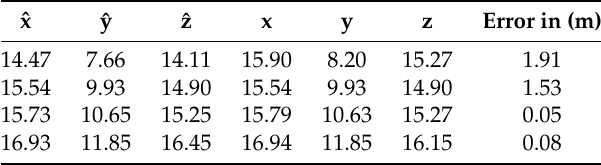
Table 2. Localization error of four nodes in each PLD